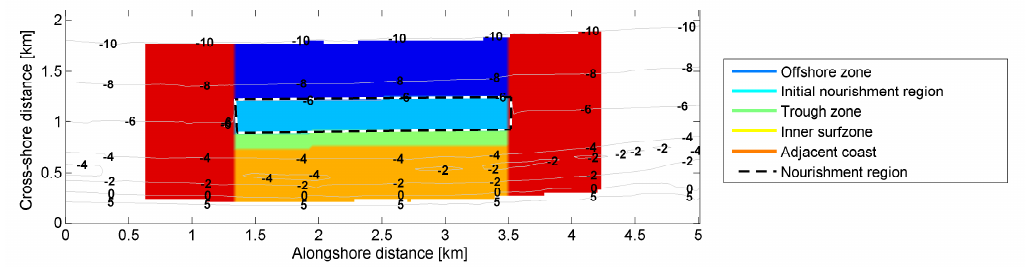
Figure 2. Example of defined volumetric integration regions for the Katwijk’98 shoreface nourishment. Contours with respect to mean sea level